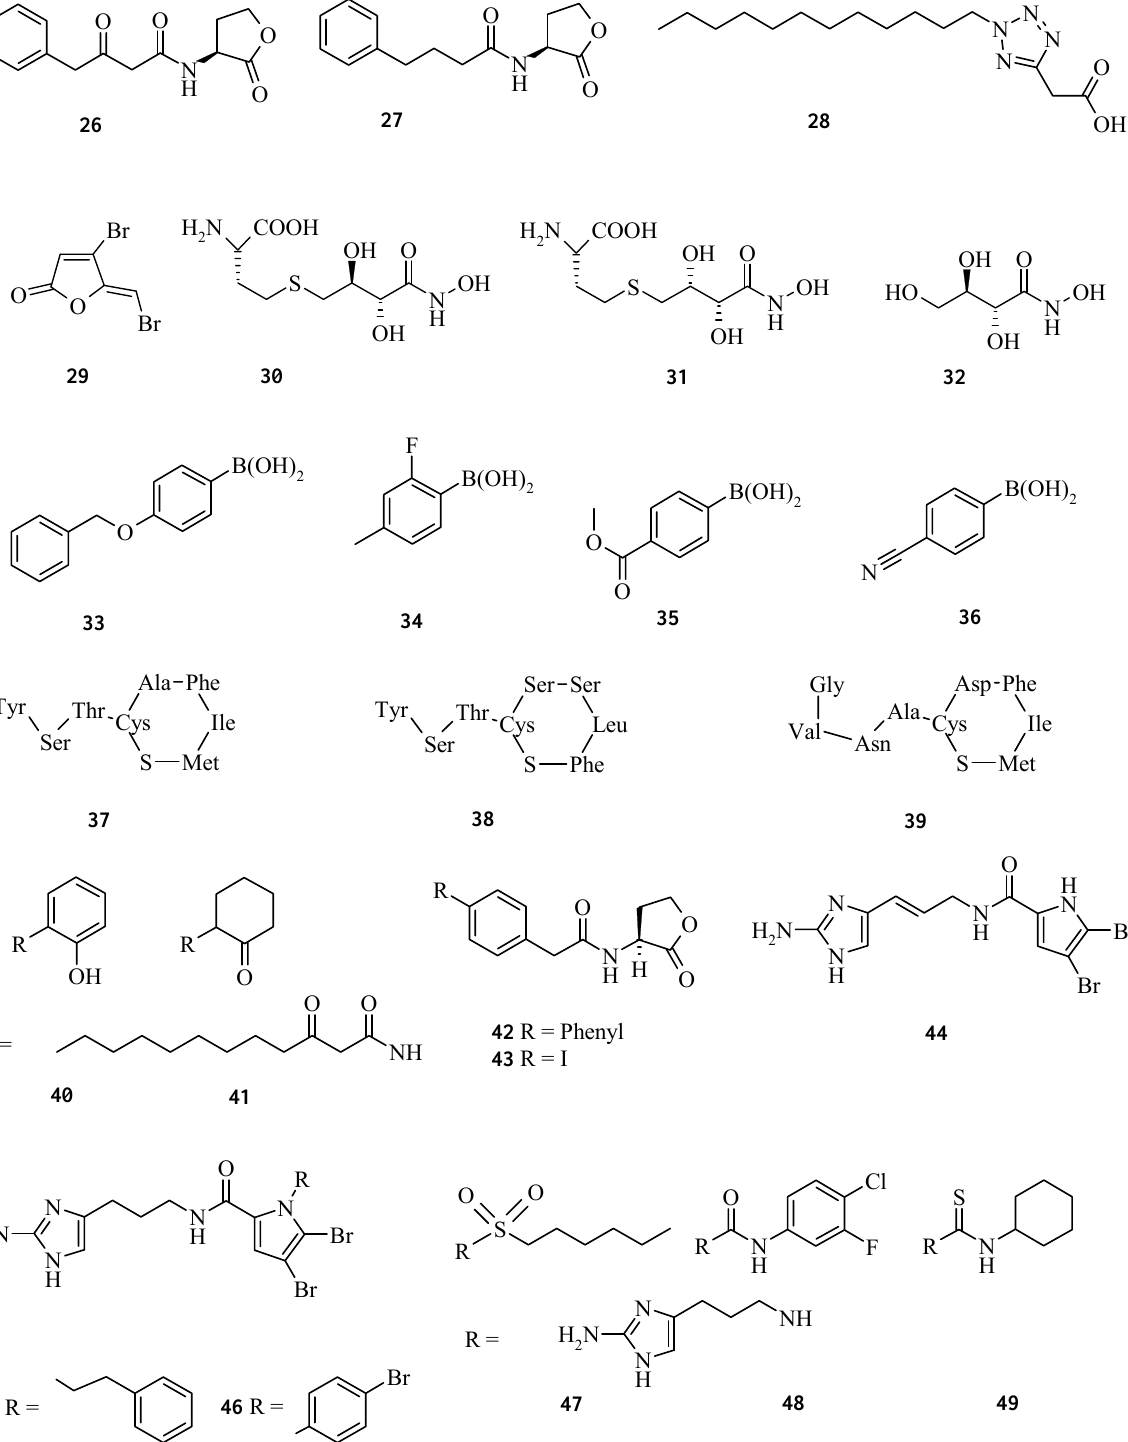
Figure 3. Synthetic compounds derived from autoinducers, or natural biofilm-controlling compounds as a lead or found in combinatorial chemistry